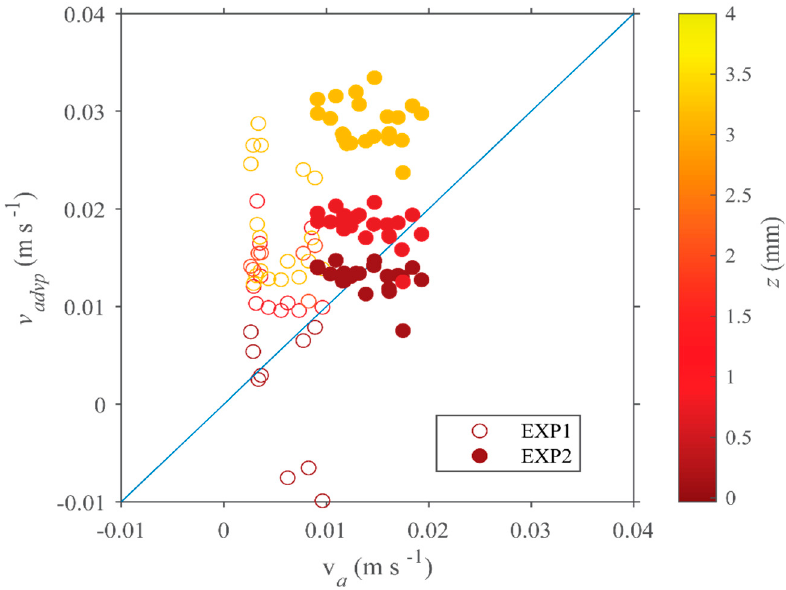
Figure 6. ADCP vs. ADVP velocities in the last three cells close to the immobile bed, and z is the distance to the immobile sediment bed (e.g., z = 0). The dark red color of the colormap symbolizes the immobile sediment bed.